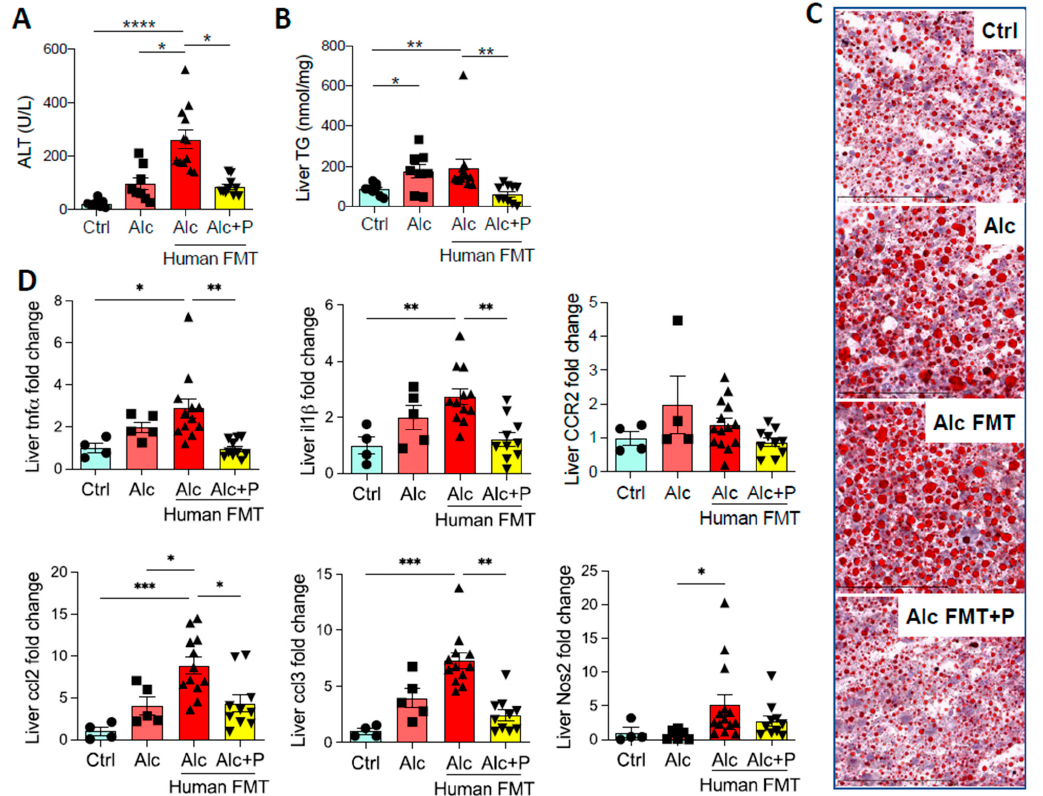
Figure 1. Liver injury in control and alcohol-fed mice and pectin-treated alcohol-fed mice . Control (Ctrl) and Alcohol-fed (Alc) mice received a Lieber DeCarli diet with isocaloric maltodextrin or alcohol, respectively. Pectin-treated mice (Alc + P) received 6.5% pectin in addition to 5% ethanol. Human fecal microbiota transfer (FMT) groups received microbiota from a patient